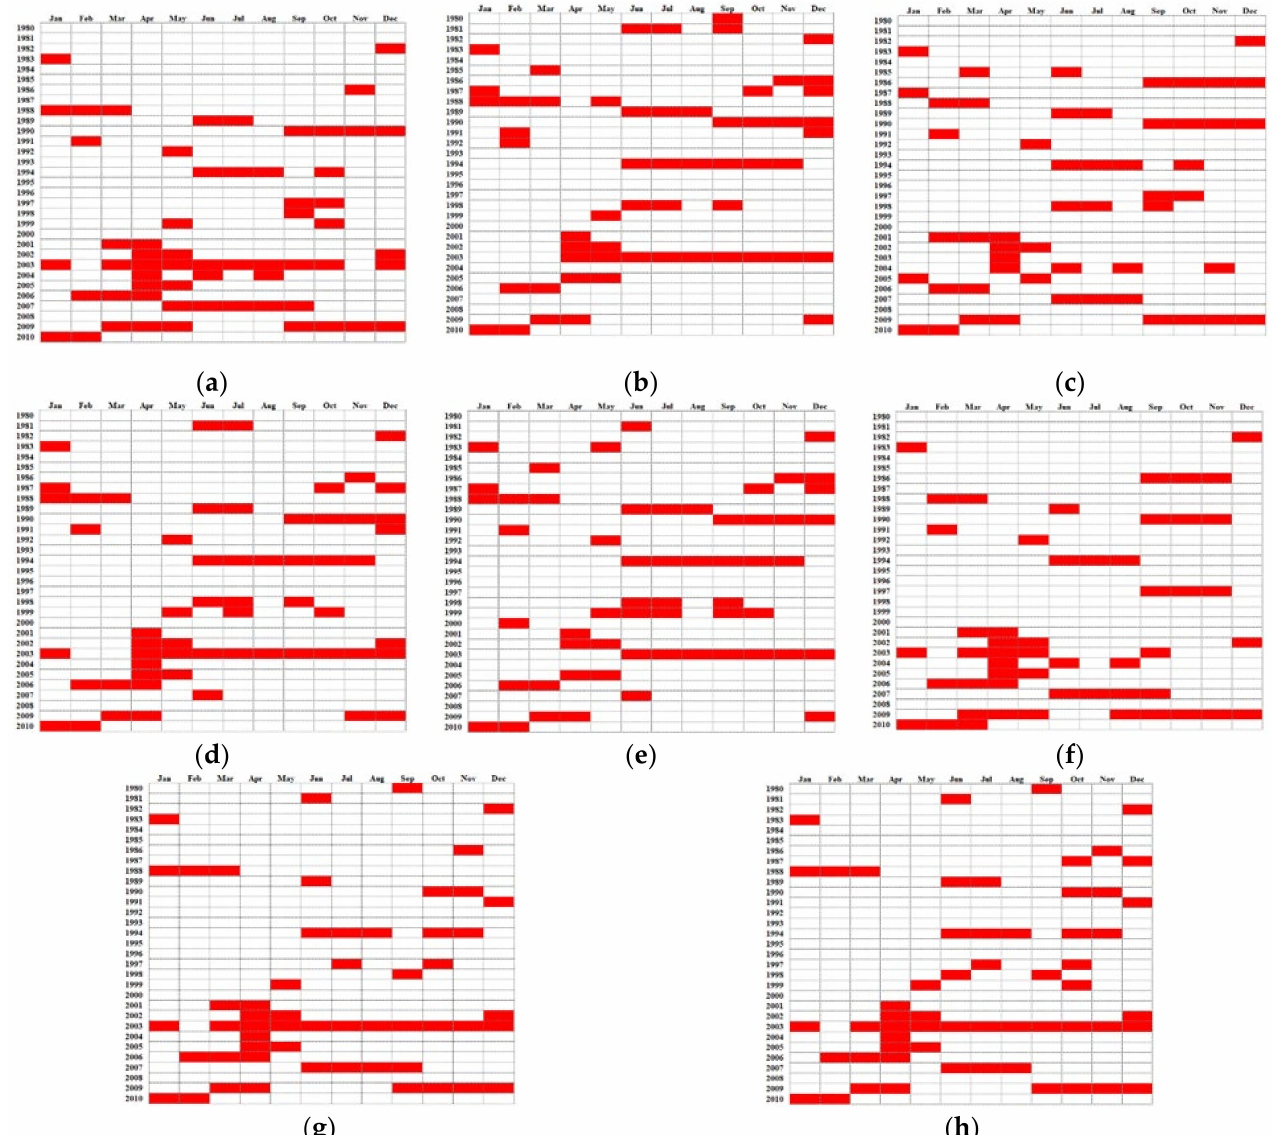
Figure 4. Droughts calculated with SEDI06 (1980–2010): ( a ) Acelhuate sub-basin; ( b ) Guajillo sub-basin; ( c ) Lempa1 sub-basin; ( d ) Lempa2 sub-basin; ( e ) Lempa3 sub-basin; ( f ) SS3 sub-basin; ( g ) SS6 sub-basin; ( h ) Suquioyo